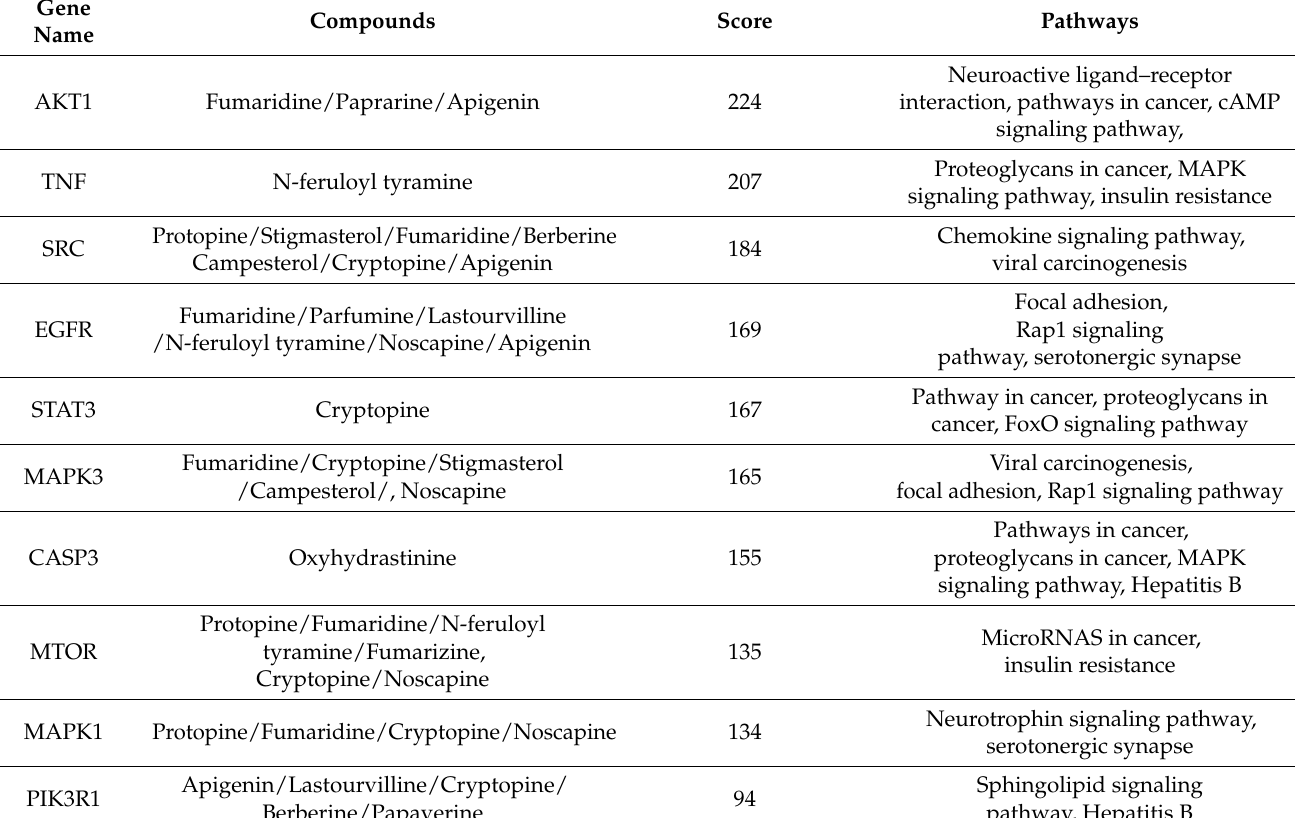
Table 3. Top 10 genes ranked by degree